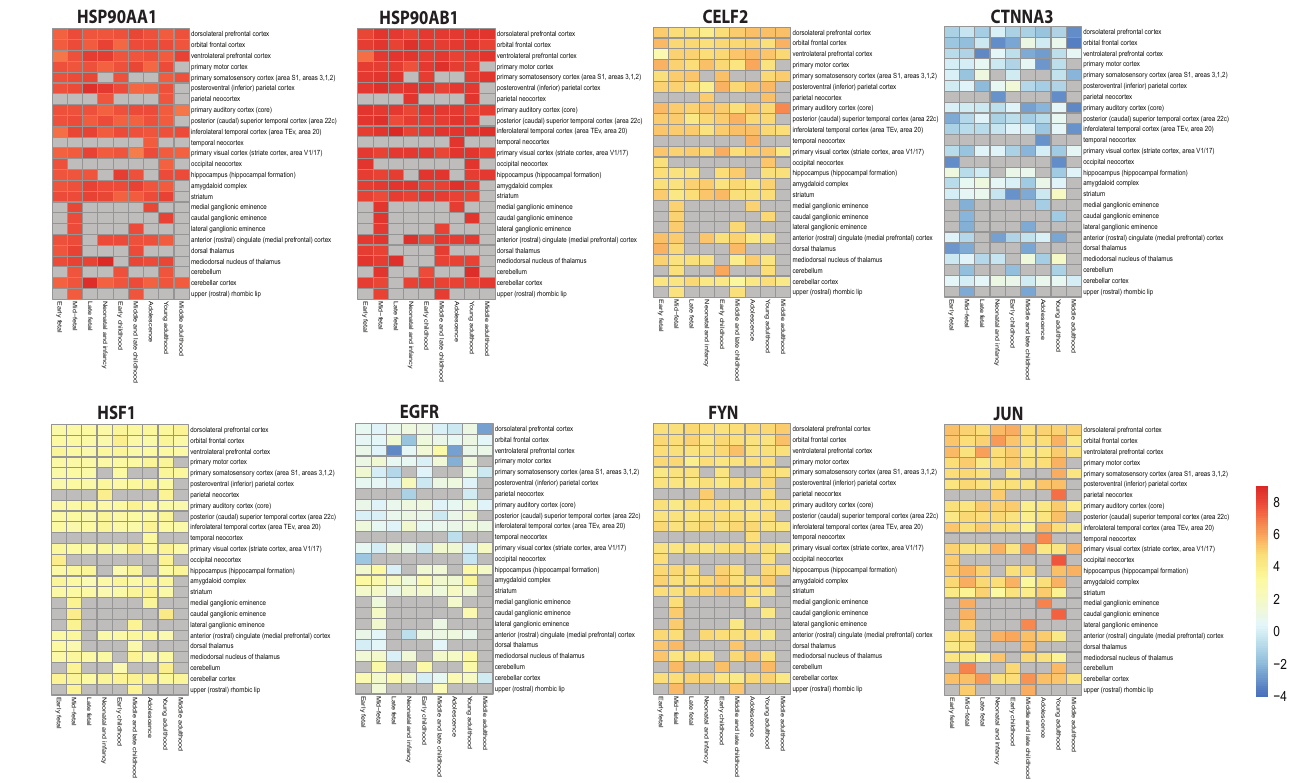
Figure 7. Spatiotemporal expression heatmap of key regulators from BEST